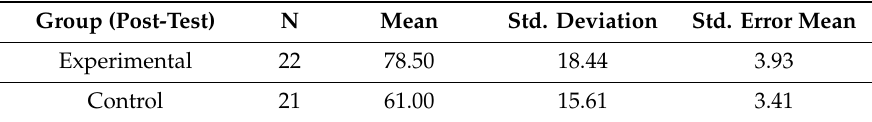
Table 4. Performance statistics after the intervention.